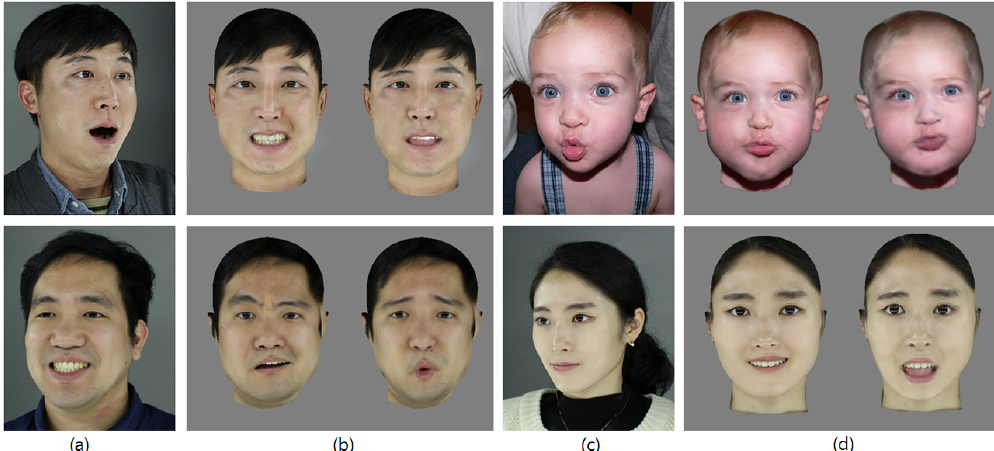
Figure 16. Synthesized expression wrinkles in faces: ( a,c ) Input images. ( b,d ) Synthesized expression wrinkles in target